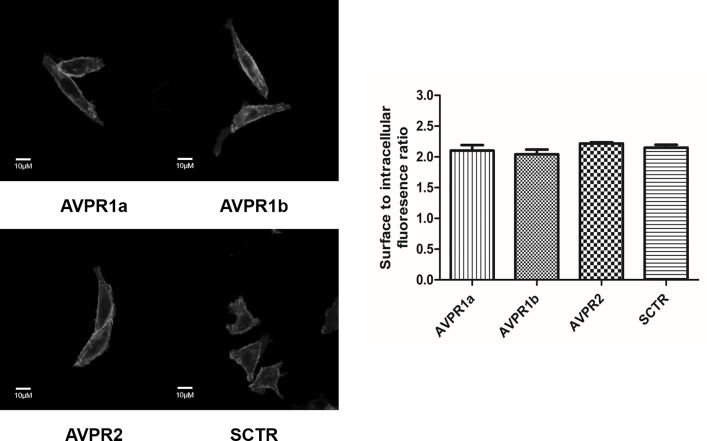
Surface expression of mAVPR1a, mAVPR1b, mAVPR2 and mSCTR are similar.Shown are representative images of CHOK1 cells expressing mAVPR1a/mAVPR1b/mAVPR2 or mSCTR constructs. Surface to intracellular fluorescence ratios were similar for these four types of cells. The data were mean±SEM from three independent experiments with 5–6 ROIs per sample. Scale bar, 10μM.